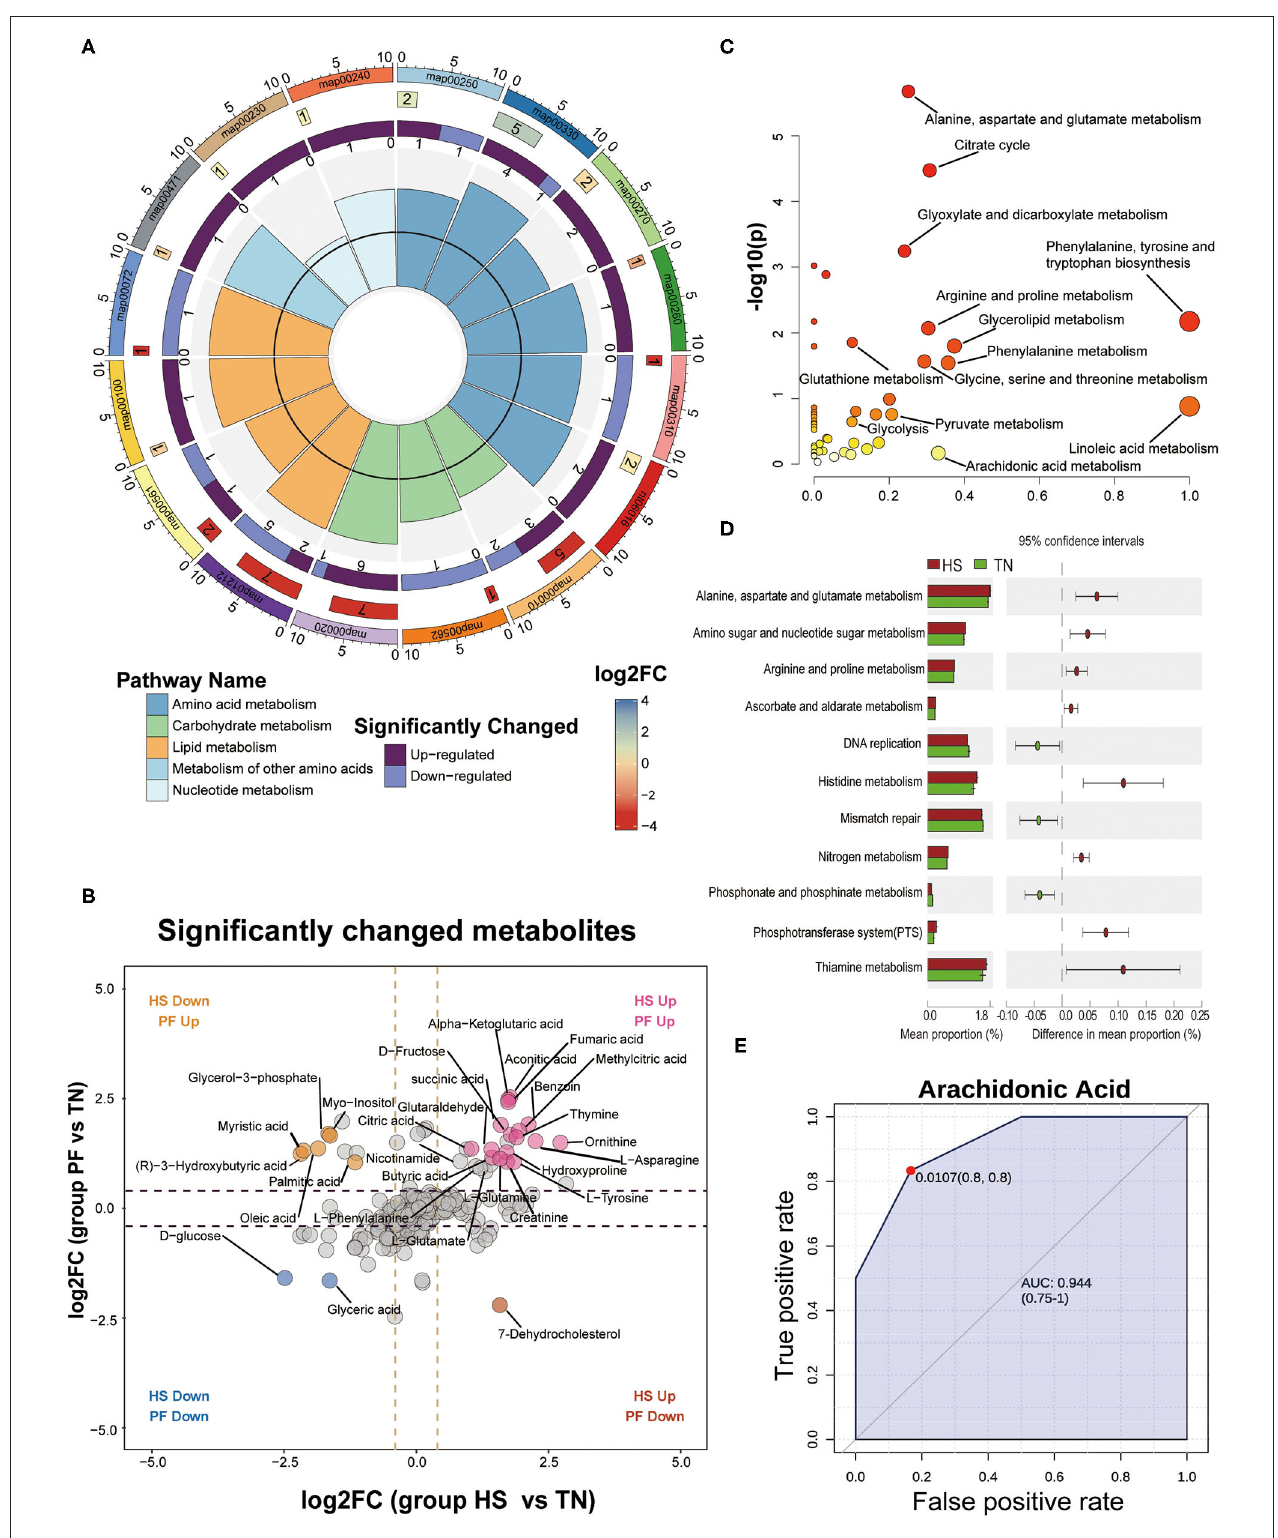
FIGURE 7 | Detection and identification of differential metabolites and further classification into different metabolic pathways by KEGG analysis. (A) An enrichment cycle diagram (HS vs. TN) including four circles from the outside to the inside, representing a KO identifier, the number of differential metabolites in the categories,